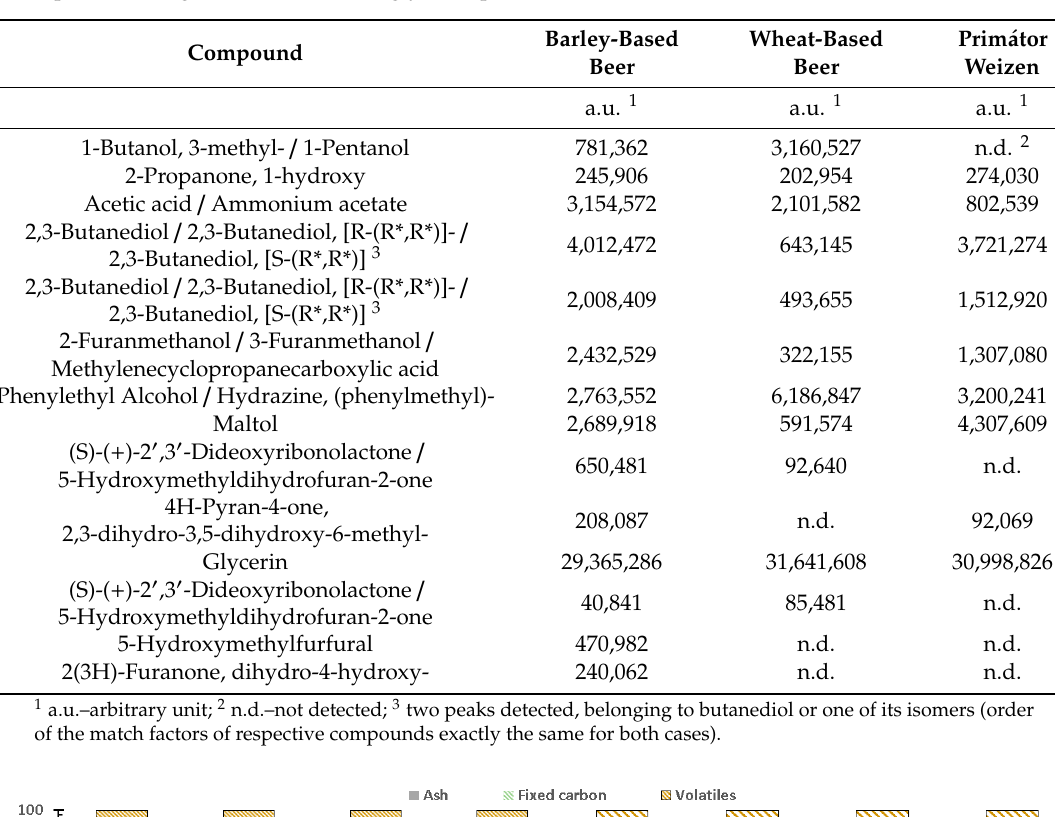
Figure 4. Higher heating value of feedstocks and respective hydrochars.